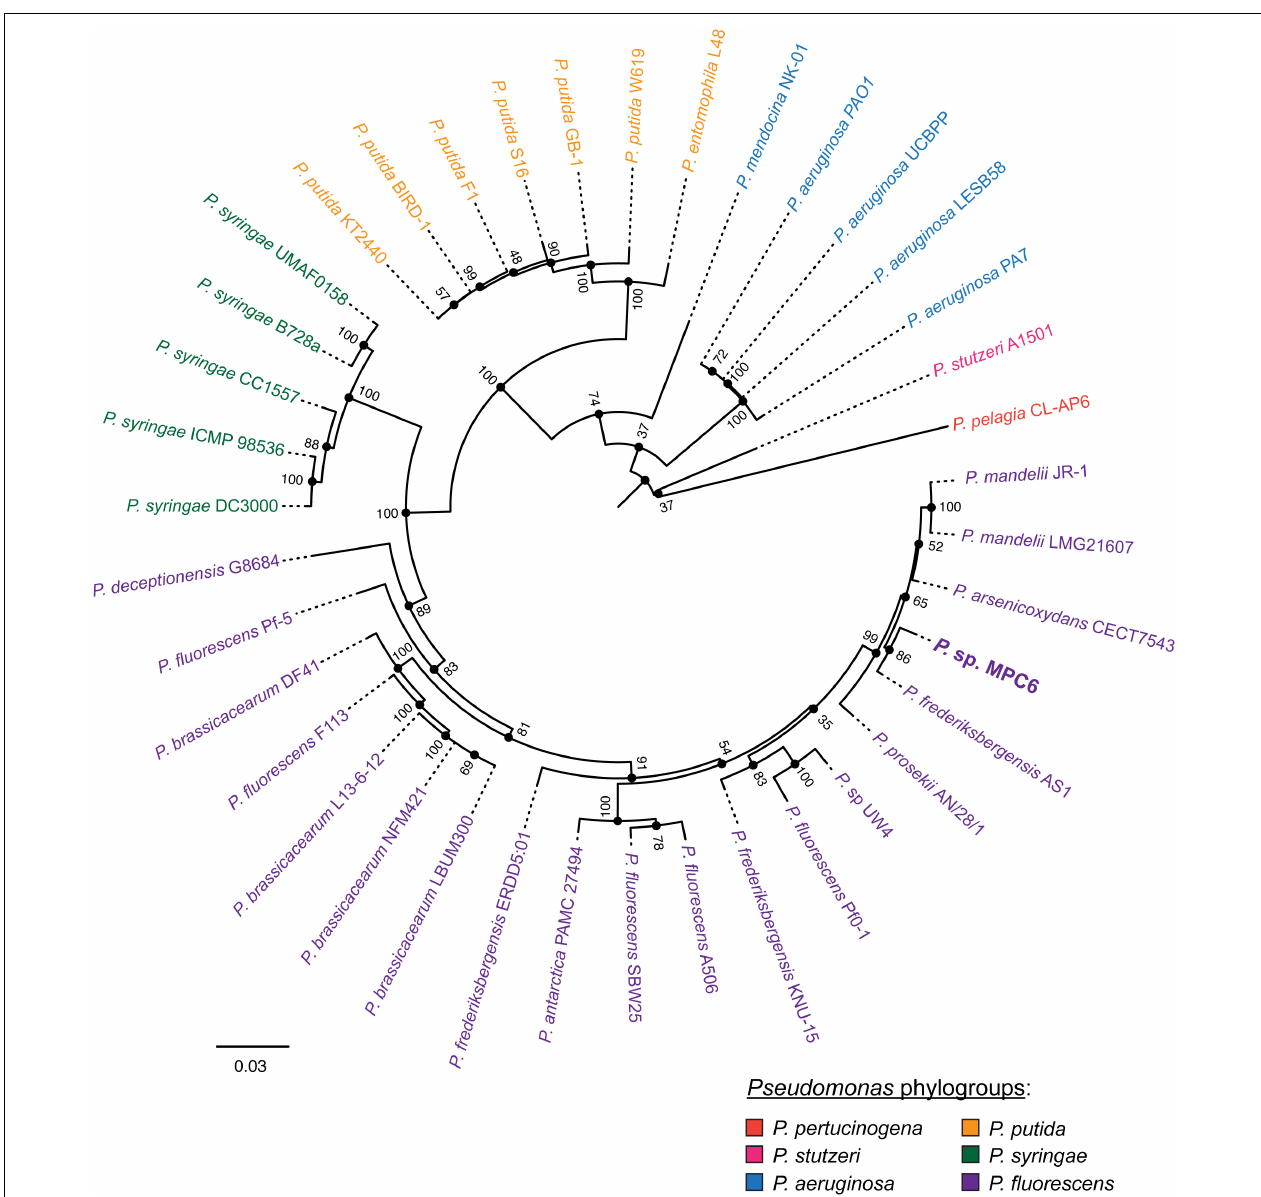
FIGURE 2 | Phylogenetic relationships between Pseudomonas sp. MPC6 and other strains from this genus. The distance tree was calculated in base to a core genome multilocus sequence analysis as described in the “Materials and Methods” section. The different colors indicate the main phylogroups proposed to compose the genus Pseudomonas (Peix et al., 2018). The numbers aside each node indicate the bootstrap support calculated from 100 replicates. A complete description of the strains used to construct this tree is provided in the Supplementary Table S2